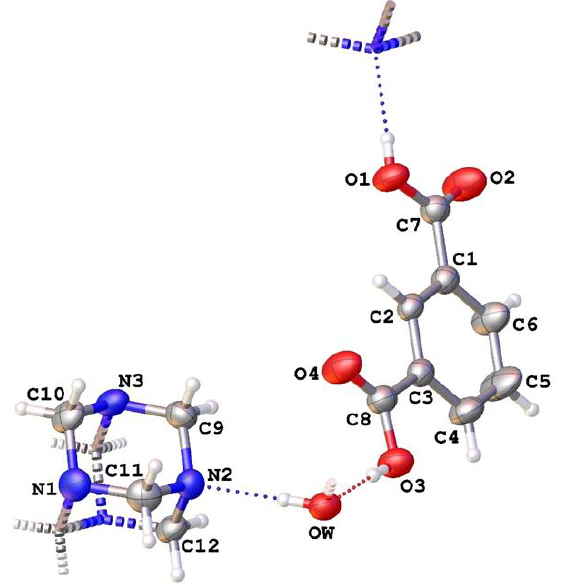
Figure 1. ORTEP diagram of the asymmetric unit of compound 1 . The hydrogen interactions are represented by dotted lines.